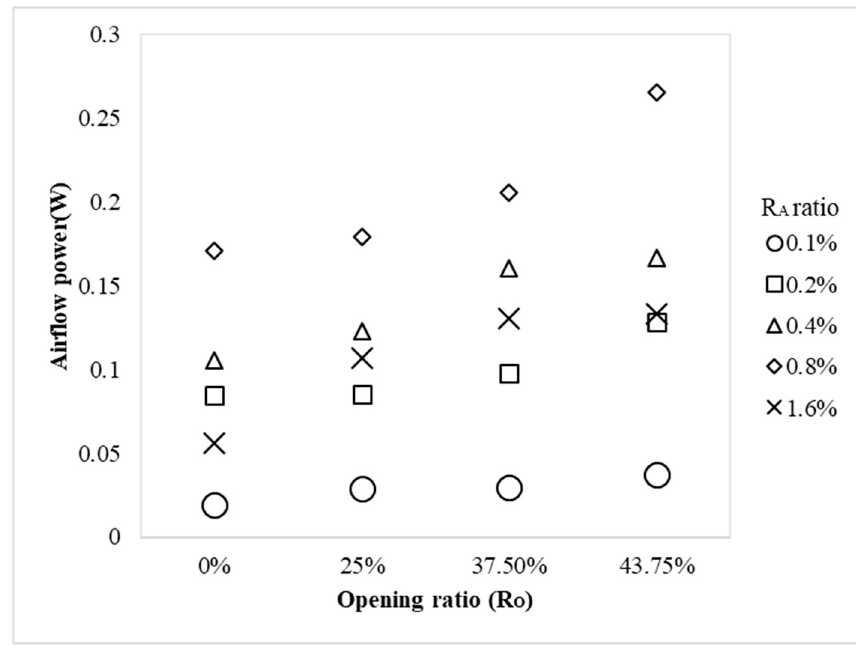
Figure 14. Pneumatic power corresponding to opening ratio of OWC gate.